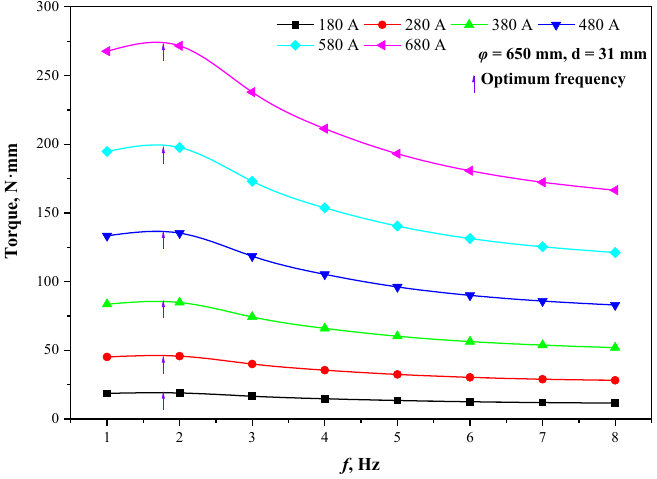
Figure 9. Torque at different current parameters.